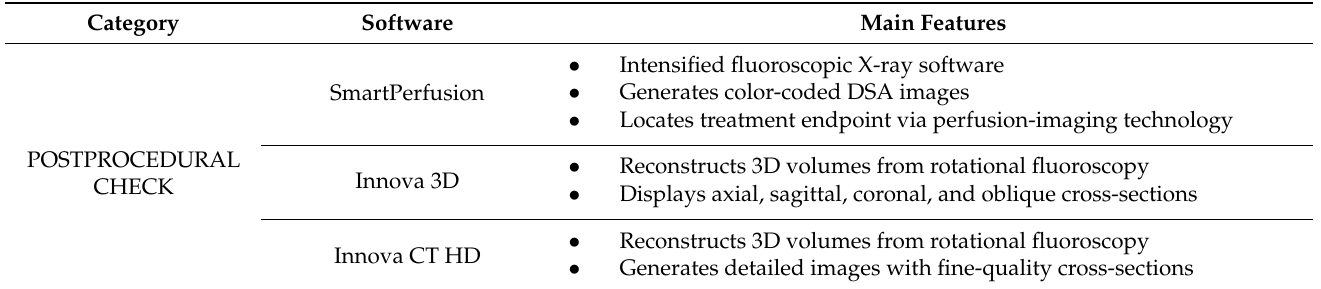
Table 5. Summary of commonly available (POSTPROCEDURAL CHECK) procedural software used in interventional